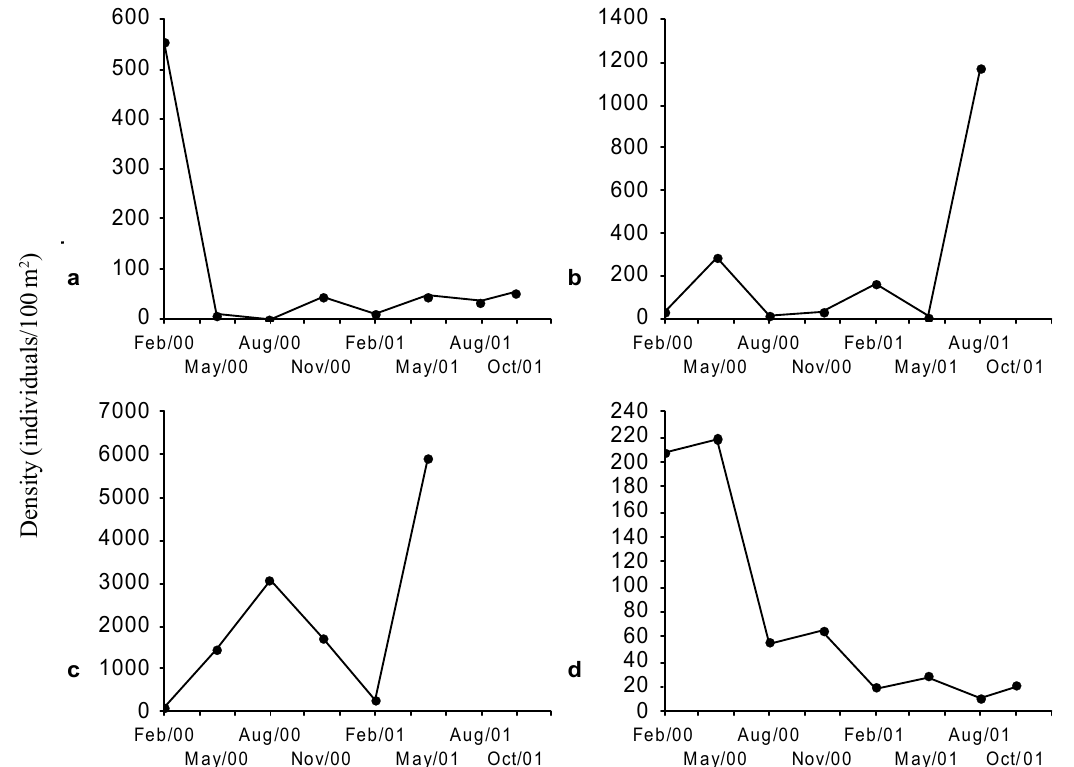
Figs. 2a-d. Temporal variation in the abundance of Serrapinnus notomelas in lagoons Capivara (a), Clara (b), Pousada (c) and Traíra